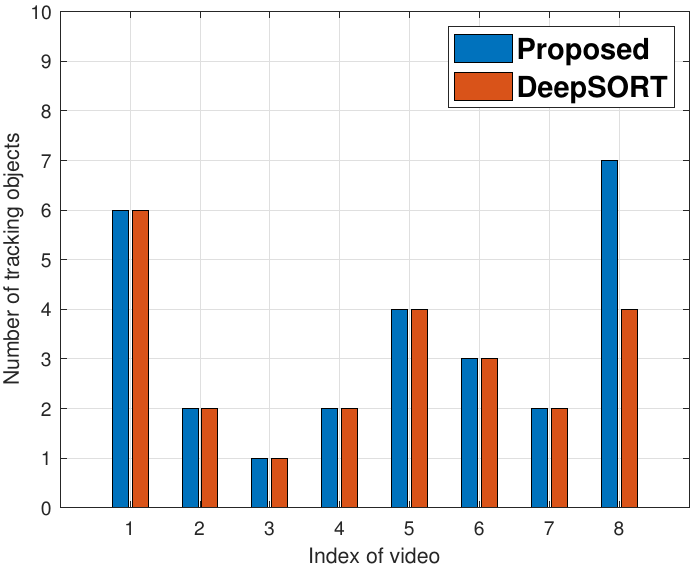
Figure 11. The number of tracking